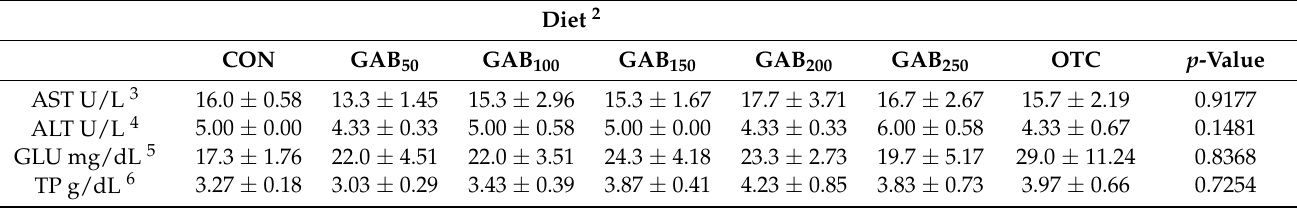
Table 4. Blood chemistry of juvenile olive flounder 1.